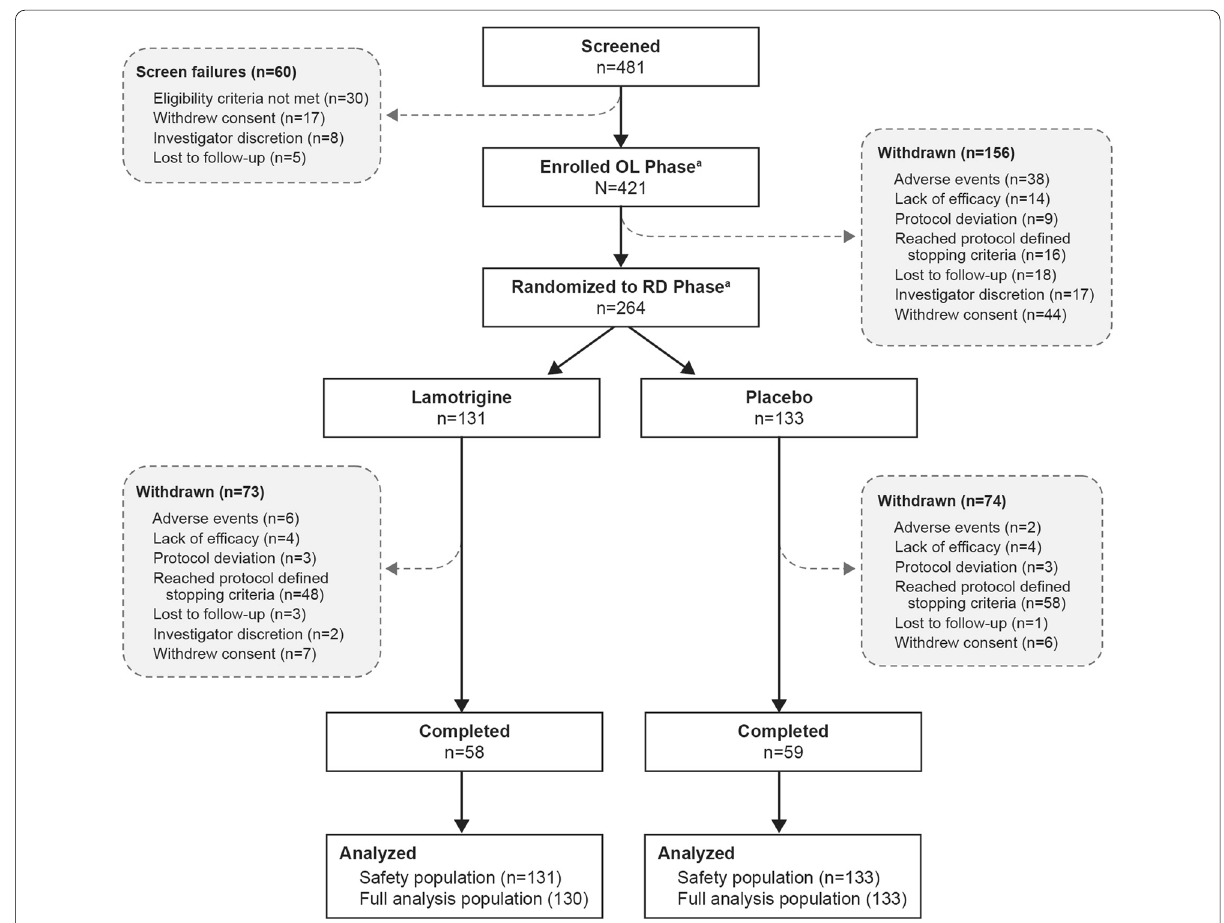
Fig. 1 CONSORT flow diagram. a One patient was enrolled to OL phase but did not receive any treatment. The stopping criteria was defined as a CGI‑S score of 3 for at least 6 consecutive weeks. CGI‑S, Clinical Global Impression–Severity; RD, double‑blind; OL, ≤